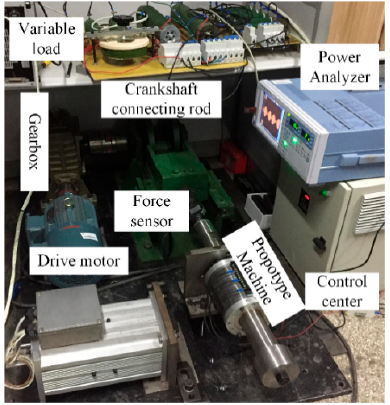
Figure 14. The test platform of MI-TLPMG for wave energy conversion systems.